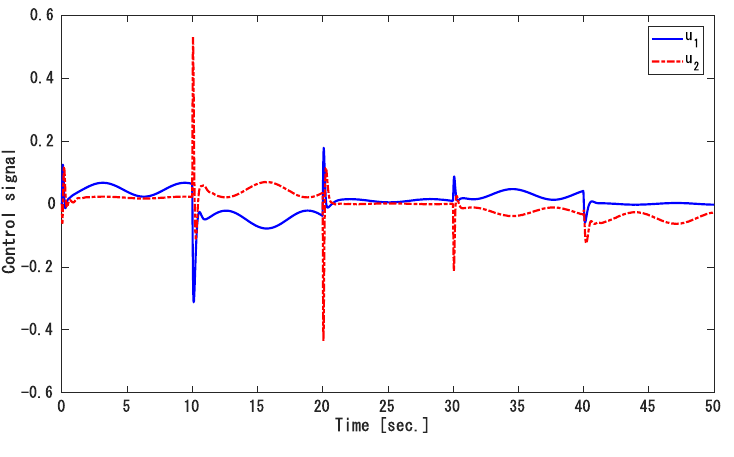
Figure 11. Control signal.